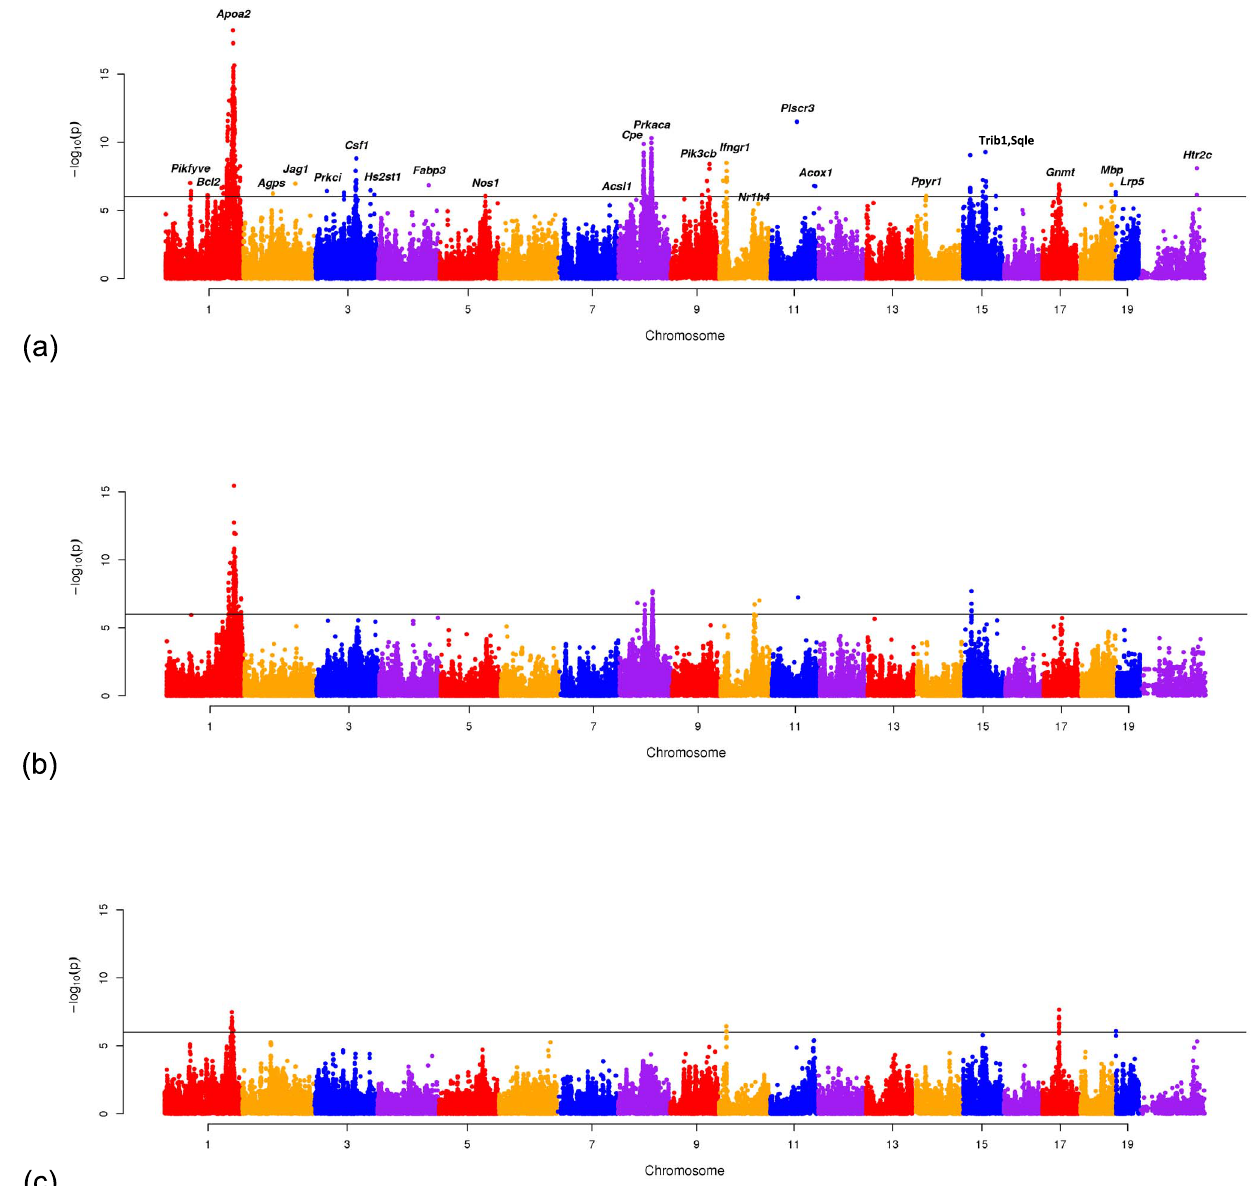
Figure 5. Manhattan plots showing the results of Meta-GxE applied to (a) 17 HDL studies, (b) 9 HDL studies consisting only of male animals and (c) 8 studies consisting only of female animals.